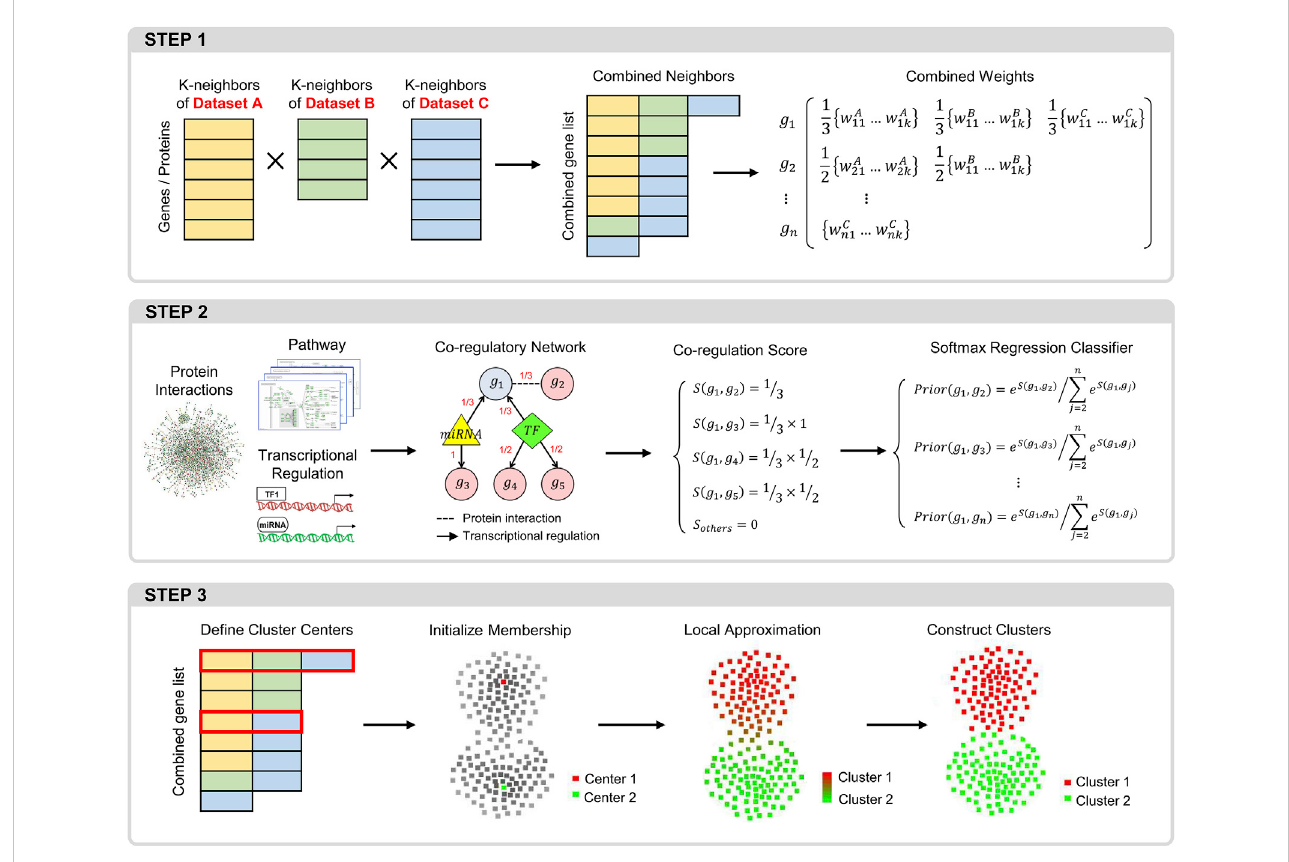
FIGURE 1 Overview of the CLAM work fl ow. Step 1: procedure for integrating the KNN matrices of different datasets into a global neighborhood matrix. Step 2: procedureforcalculating thepriorcorrelationprobabilities betweeneachgeneanditsneighbors intheneighborhoodmatrix. Step3:thelocalapproximation procedure for identifying gene